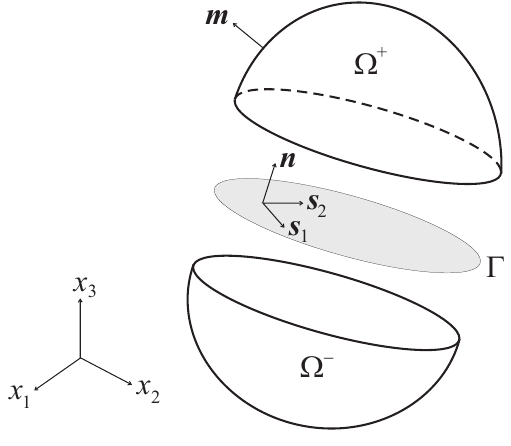
Figure 1. Geometry of a two-phase body, and